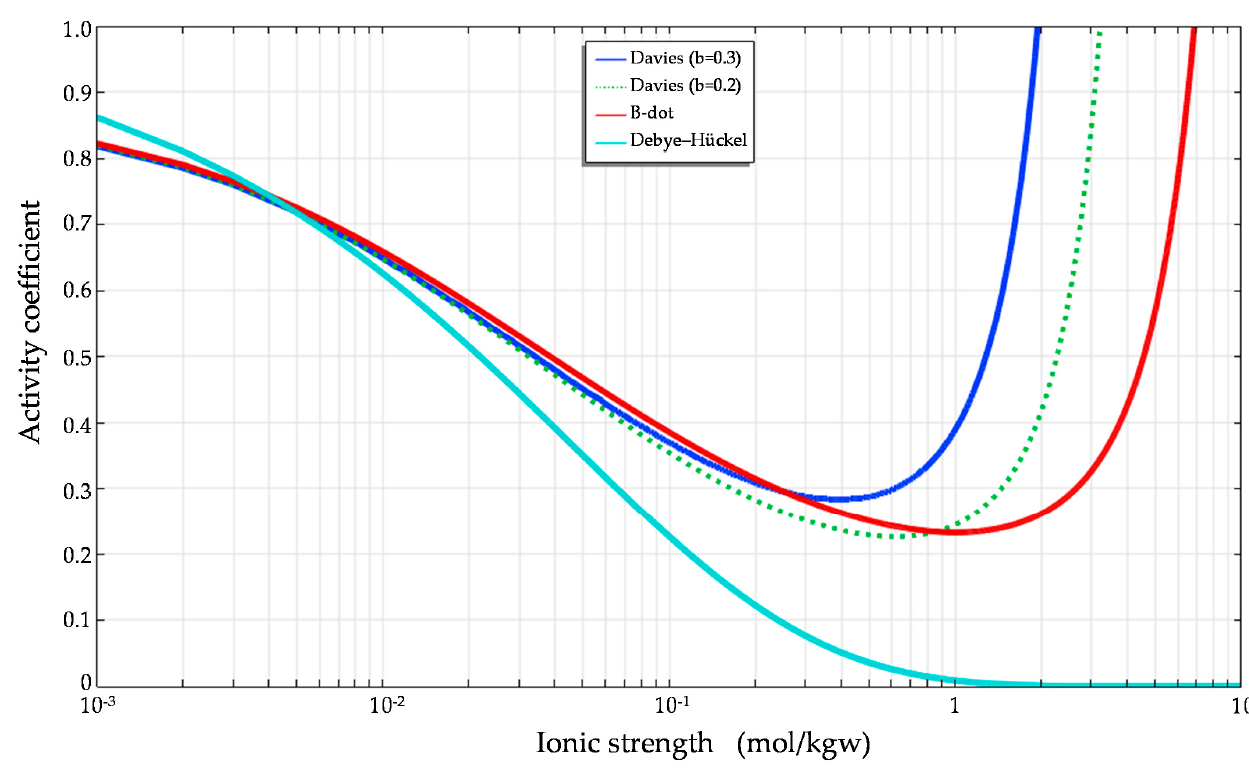
Figure 1. Change in ionic strength vs. the activity coefficients of Ca 2+ determined using the Debye–Hückel, Davies and B-dot models.